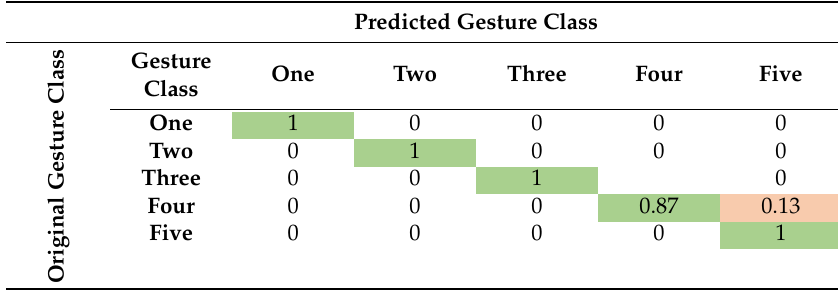
Figure 14. Training and validation accuracy of the CNN classifier. Table 3. Confusion matrix for experimental